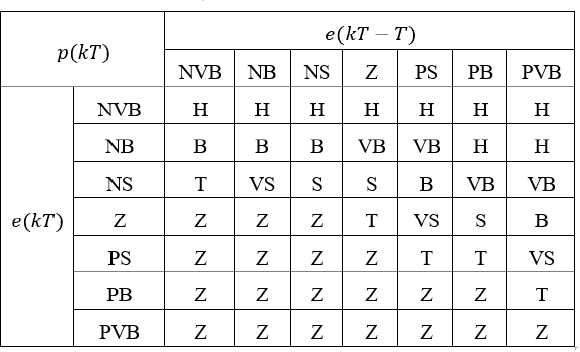
Table 1. System of law inference